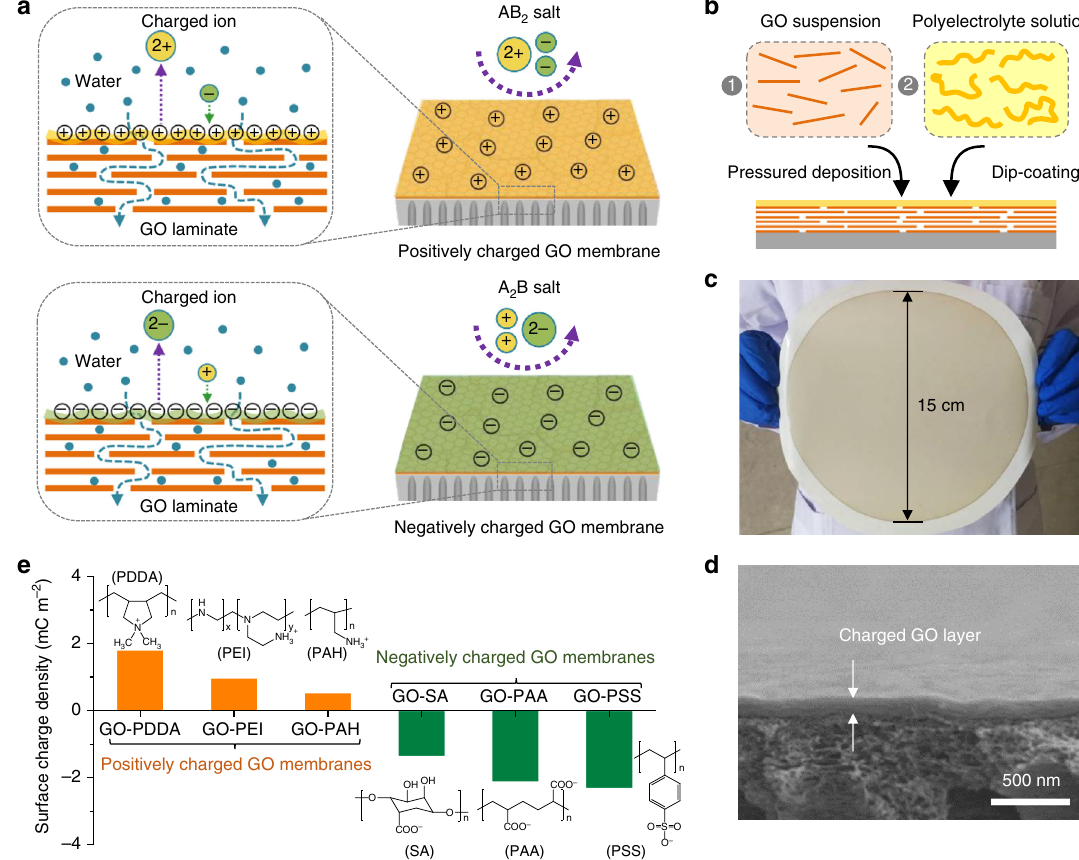
Fig. 1 Design of surface-charged graphene oxide (GO) membrane. a Schematic of the design of surface-charged GO membranes by coating polyelectrolytes on the surface of GO laminates to realize controllable ion transport. Coating polycations such as polydiallyl dimethyl ammonium (PDDA), polyethylene imine (PEI), and polyallylamine hydrochloride (PAH) led the GO membrane to exclude AB 2 -type salts based on the positively charged membrane surface, which exhibits a dominant electrostatic repulsion against divalent cations A 2 + , which is favored over electrostatic attraction with monovalent anions B − ; coating polyanions such as polystyrene sulfonate (PSS), polyacrylic acid (PAA), and sodium alginate (SA) led the GO membrane to exclude A 2 B-type salts based on the negatively charged membrane surface, which exhibits a dominant electrostatic repulsion against divalent anions B 2 − , which is favored over electrostatic attraction with monovalent cations A + . b Schematic of the preparation of surface-charged GO membranes. GO laminates were fi rst prepared by fi ltrating GO aqueous suspension on a porous polyacrylonitrile (PAN) substrate via pressured-assisted fi ltration – deposition method, followed by dip-coating a dilute polyelectrolyte solution on surface of pre-stacked GO laminates to form the surface-charged GO membranes. c Photograph of large-area surface-charged GO membrane (GO deposition amount of 5 mg with 0.1 wt% PDDA polyelectrolyte surface coating) with a diameter of 15 cm (effective area: ~180 cm 2 ). d Scanning electron microscopic cross-sectional views of surface-charged GO membranes on top of a porous PAN substrate (GO deposition amount of 0.5 mg with 0.1 wt% PEI polyelectrolyte surface coating; membrane diameter of 4.7 cm with effective area of ~17.35 cm 2 ). e Surface charge densities of surface-charged GO membranes calculated from the measured membrane zeta potentials based on Gouy – Chapman theory. Insets are molecular structures of the surface polyelectrolytes with ionized functional